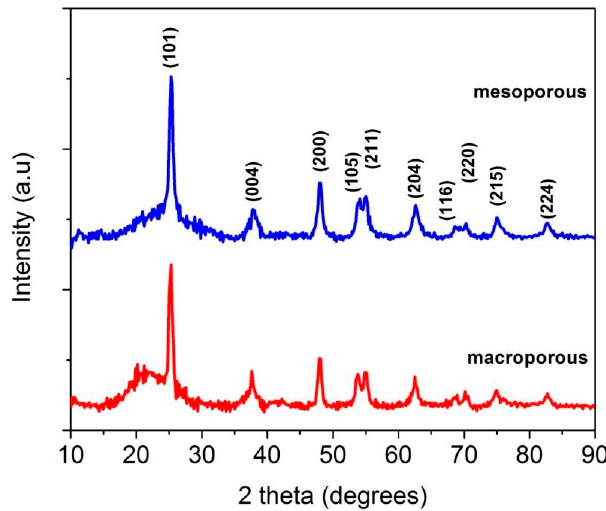
Figure 3. XRD of macroporous and mesoporous nanocomposites revealing the presence of anatase phase in an amorphous SiOC matrix (JCPDS card No. 20-2242). Materials 2018 , 11 , x FOR PEER REVIEW